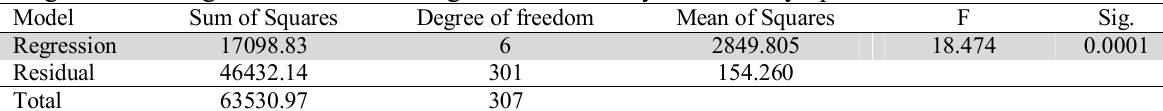
Regression of anger and sadness management on anxiety disorders symptoms Model Sum of Squares Degree of freedom Mean of Squares F Sig. Regression 17098.83 6 0.0001 Residual 46432.14 301 154.260 Total 63530.97 307